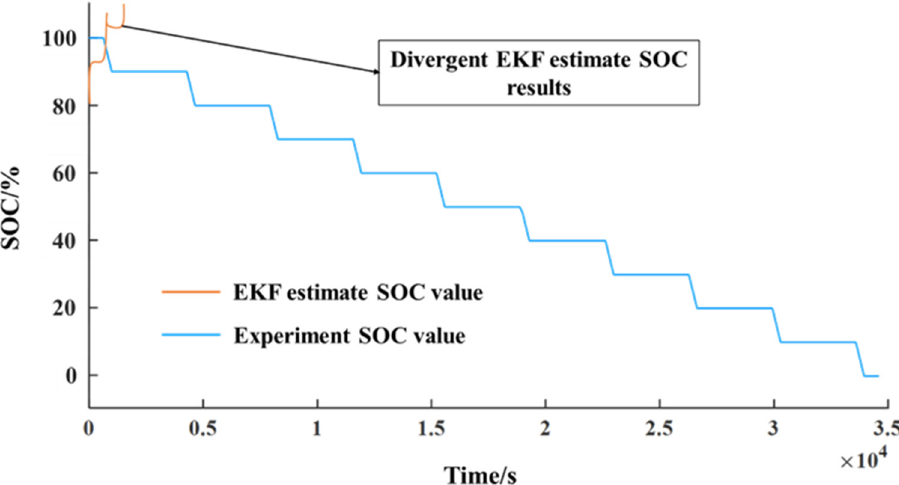
Figure 8. Divergent SOC estimation results using EKF.